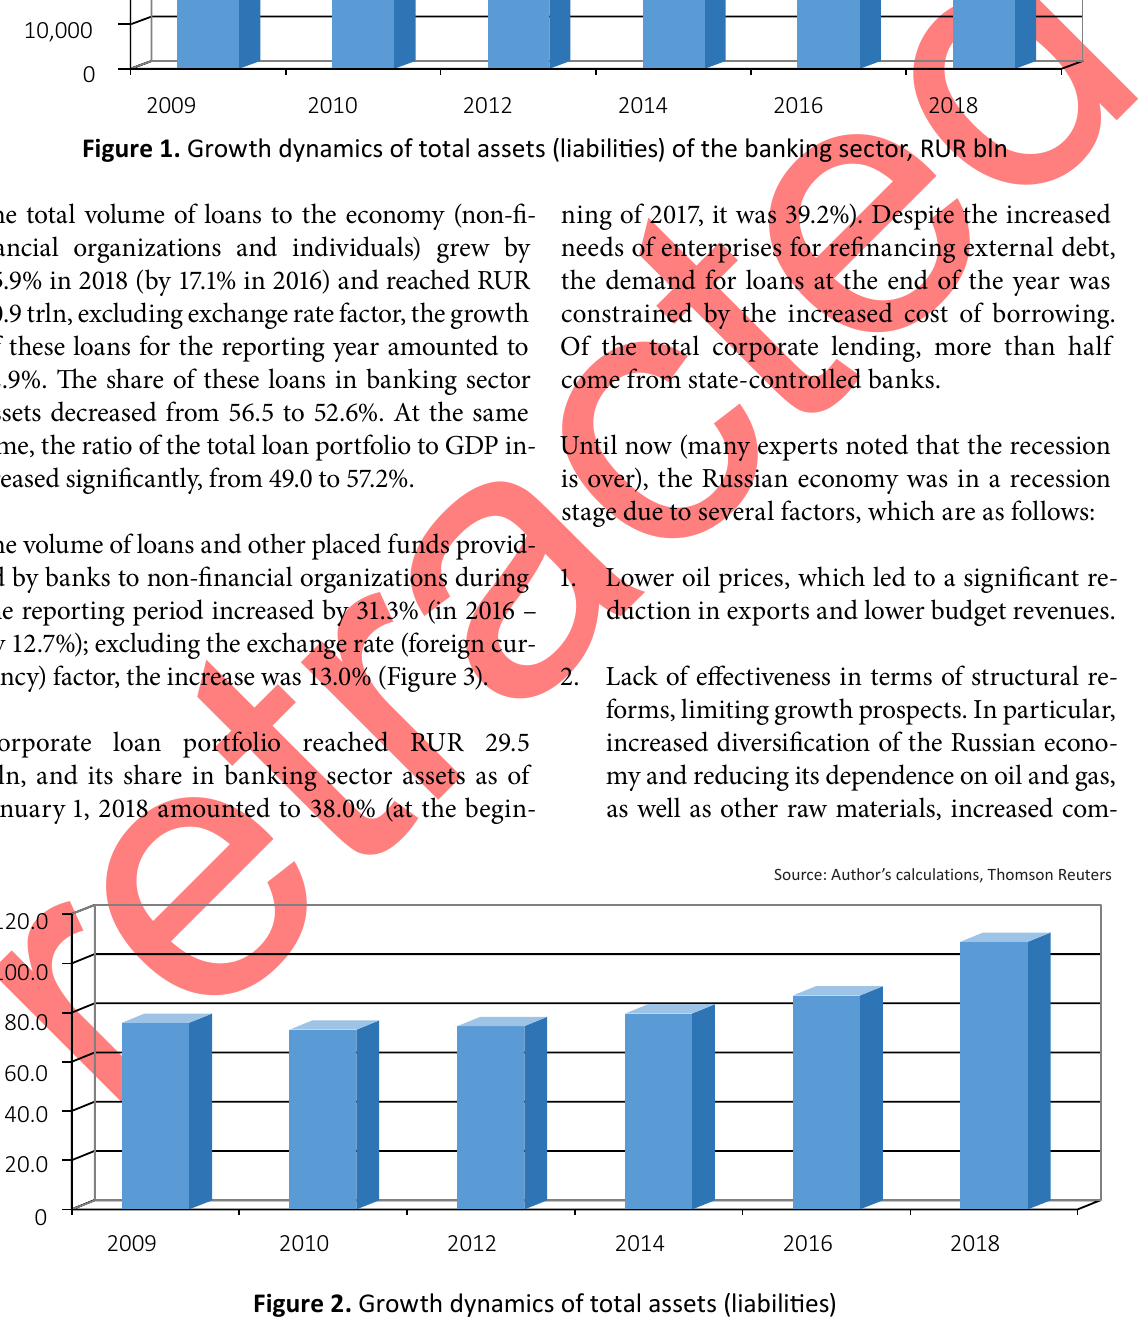
Figure 1. Growth dynamics of total assets (liabilities) of the banking sector, RUR bln